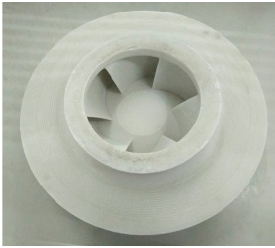
Figure 20. 3D wax pattern.